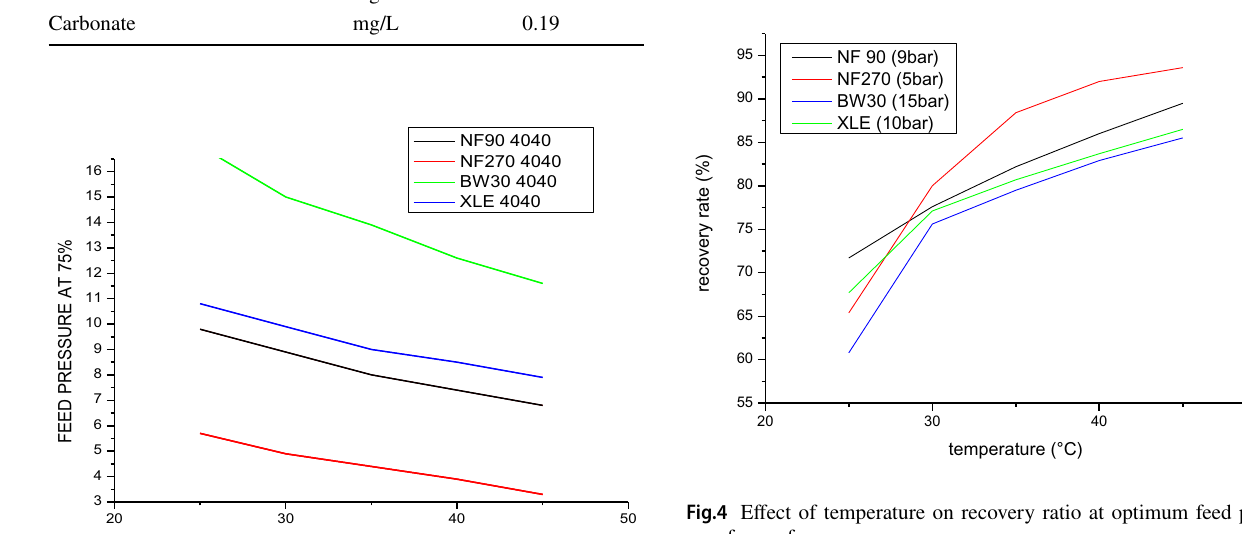
Fig.4 Effect of temperature on recovery ratio at optimum feed